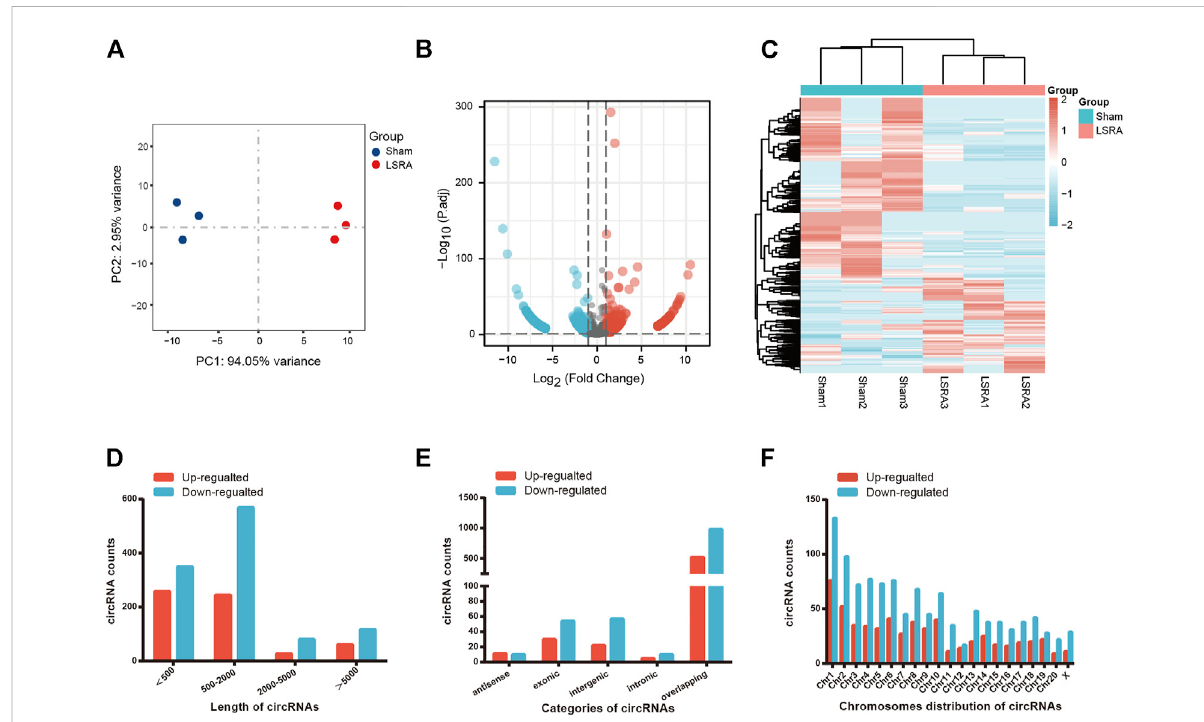
FIGURE 1 Theexpressionpro fi lesofcircRNAs. (A) PCAanalysisshowingdistinctclusteringoftheindividualsamplesofShamandLSRAgroups. (B) Volcano plot of circRNA expression ( n = 3). (C) Hierarchical clustering analysis of circRNAs that were markedly differentially expressed (|fold change| ≥ 2 and p < 0.05) between the two groups ( n = 3). (D) Length distributions of differentially expressed circRNAs. (E) Five categories of circRNAs based on genomic origin. (F) Distribution of the differentially expressed circRNAs on the rat chromosomes. circRNAs, circular RNAs; LSRA, lumbosacral spinal root